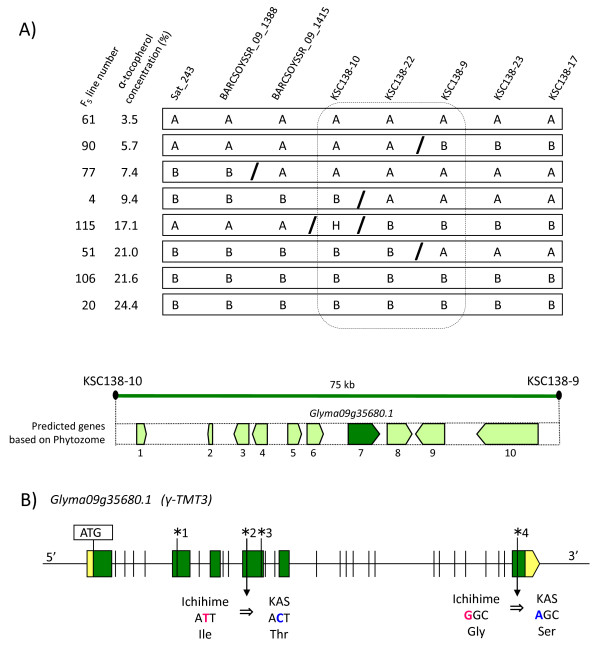
Graphical genotypes of recombinant plants selected from fine mapping and gene structure of γ-TMT3. (A). Summary of informative F5 plant lines used for fine mapping of the QTL responsible for high α-tocopherol concentration. Ichihime homozygous genotypes and KAS homozygous genotypes of each marker are represented by 'A' and 'B', respectively. Heterozygous genotype is represented by 'H'. '/' represent recombination positions. The region contributing to high α-tocopherol concentration is enclosed by a dashed box. KSC138-9 genotypes were only analyzed for these informative lines. The interval between KSC138-10 and KSC138-9 corresponded to a 75-kb sequence region on chromosome 9. Based on information from the Phytozome database, the region contained 10 predicted genes. Arrows referred to the genes and numbers below arrows correspond to the numbers in Table 2. (B). Gene structure of Glyma09g35680.1 (γ-TMT3). The green rectangles and the spaces between the green rectangles represent exons and introns, respectively. The yellow rectangle represents the 5'-UTR region, while the yellow arrow represents the 3'-UTR region. Vertical lines represent genetic polymorphisms (insertion-deletion, SNPs) between Ichihime and KAS. Nucleotide polymorphisms in the exons are indicated by vertical lines and numbers, which are summarized in Table 3. The polymorphisms numbered 2 and 4 are nonsynonymous nucleotide substitutions; the corresponding amino acid changes (Ichihime to KAS) are indicated below the substitution sites.